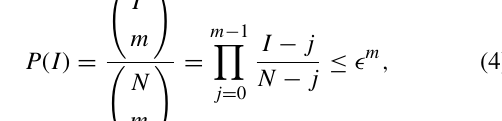
= 1 – η o , typically set to 95%) to recover maximum of the cost function J S [10,